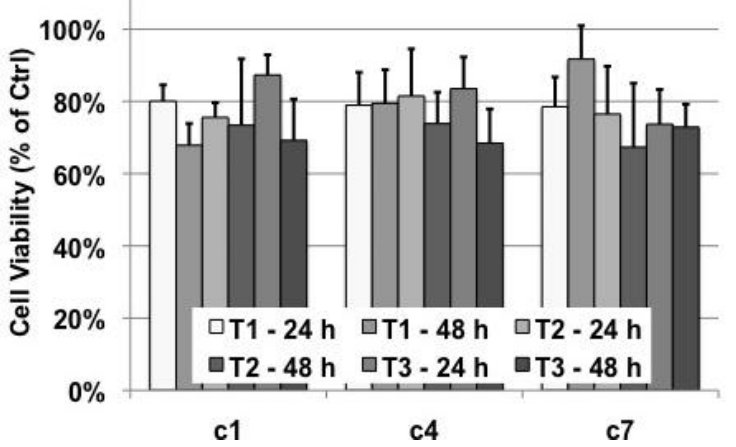
Figure 6. Results of the MTT test on collagen gel prepared at pH 10 as a function of ionic strength, temperature of gelation and the time point (24 or 48 h) at which cell viability was assessed. The results are expressed as % cell viability of the